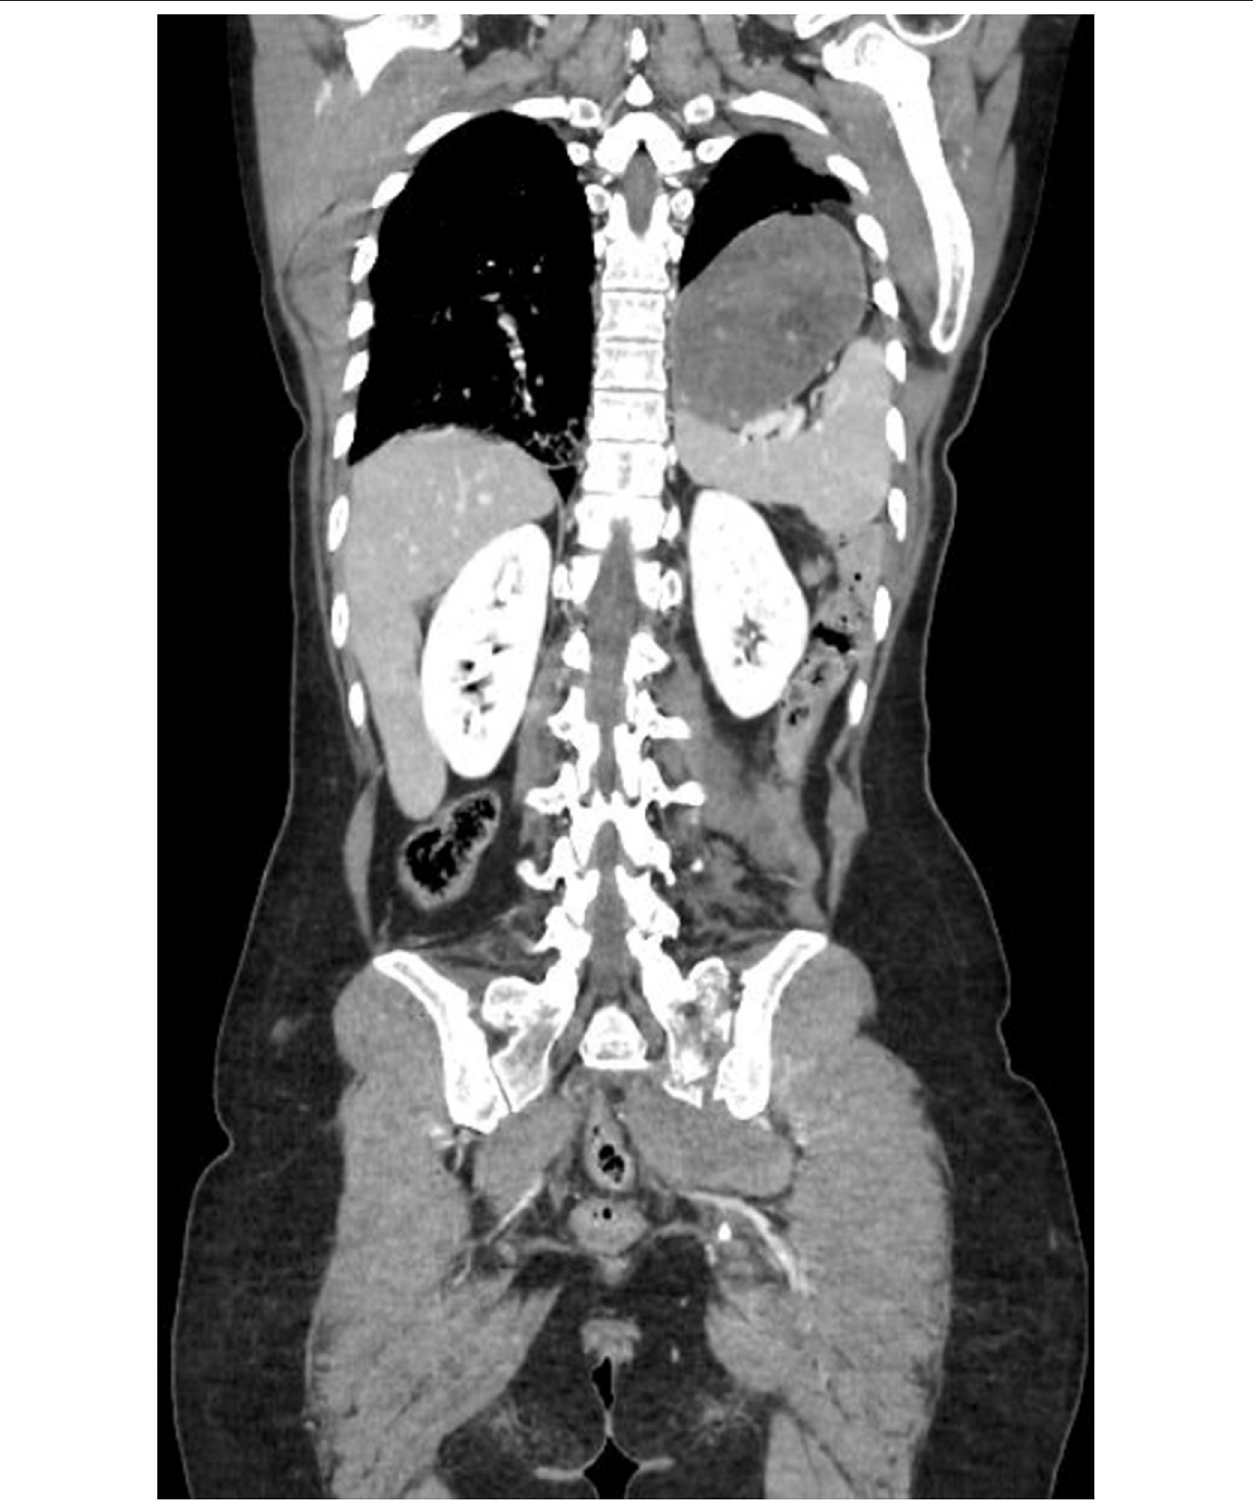
FIGURE 1 | Preoperative Thorax-Abdomen contrast-enhanced CT, showing left postero-lateral diaphragmatic lesion involving the left diaphragmatic pillar and the herniation of the stomach and the spleen in thorax, associated with a lung parenchyma compression and dislocation of the mediastinum.